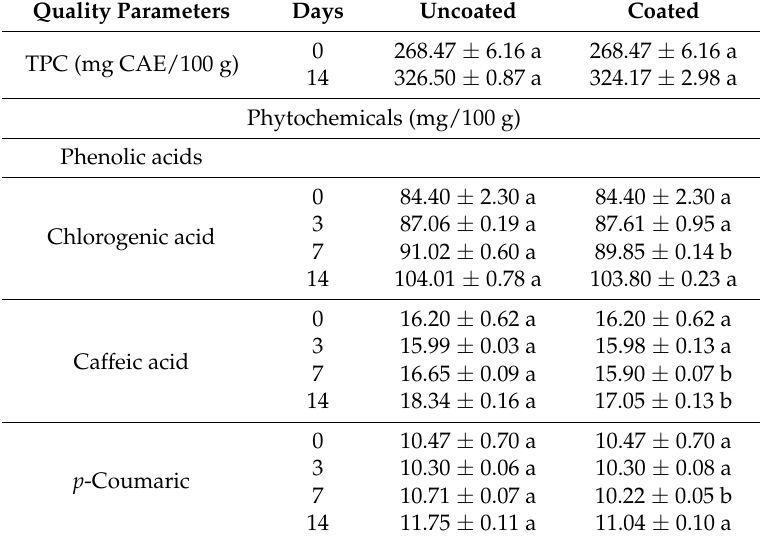
Table 4. Contents of total phenolics and phenolic acids in uncoated and coated blueberries fruit. Fruit were stored at 16 ◦ C for up to 14